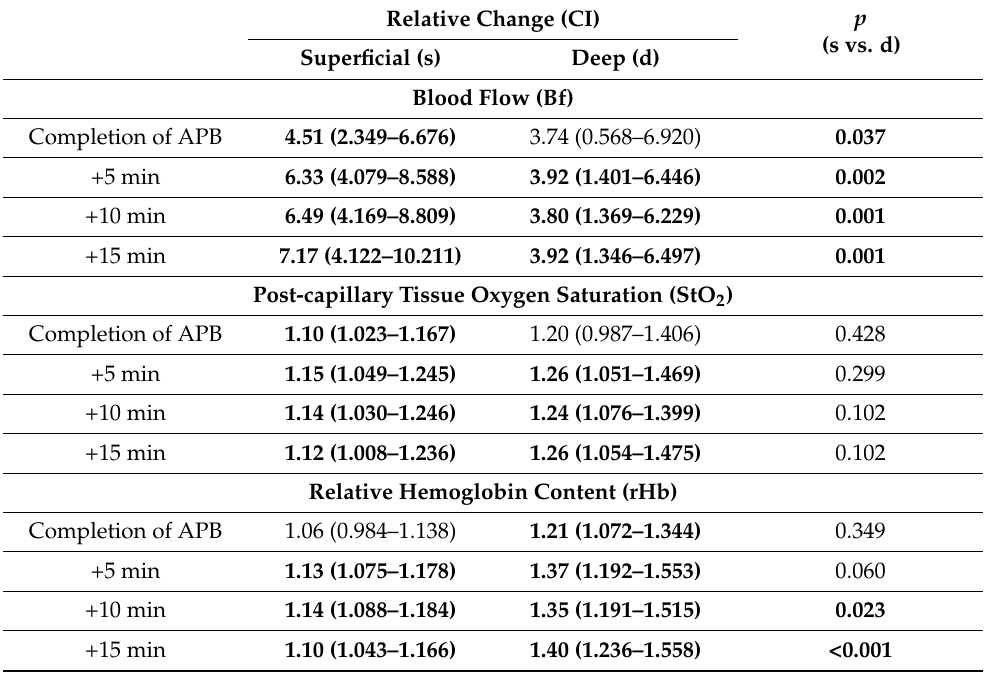
Table 1. Microcirculatory